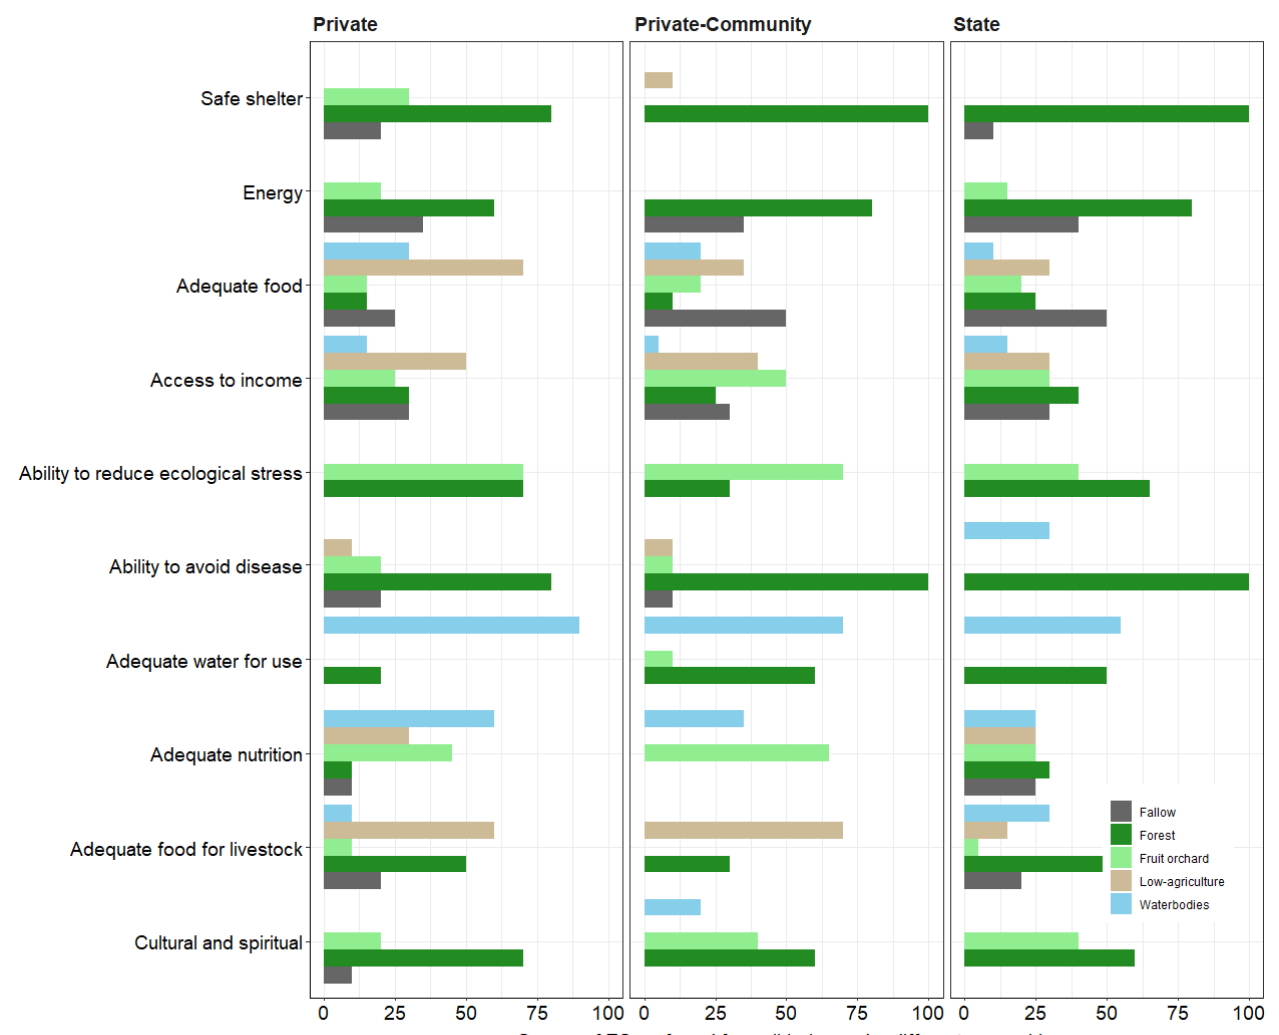
Figure 4. Variations of land use preference for ES to support well-being under different land ownership contexts. The top labels of the “x” axis show the ownership contexts. The “y” axis shows the well-being needs.